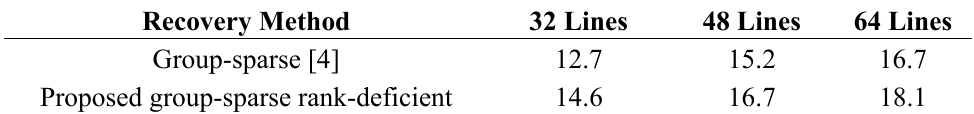
Table 3. Ex vivo : SNR for different Fourier mappings with different echoes.